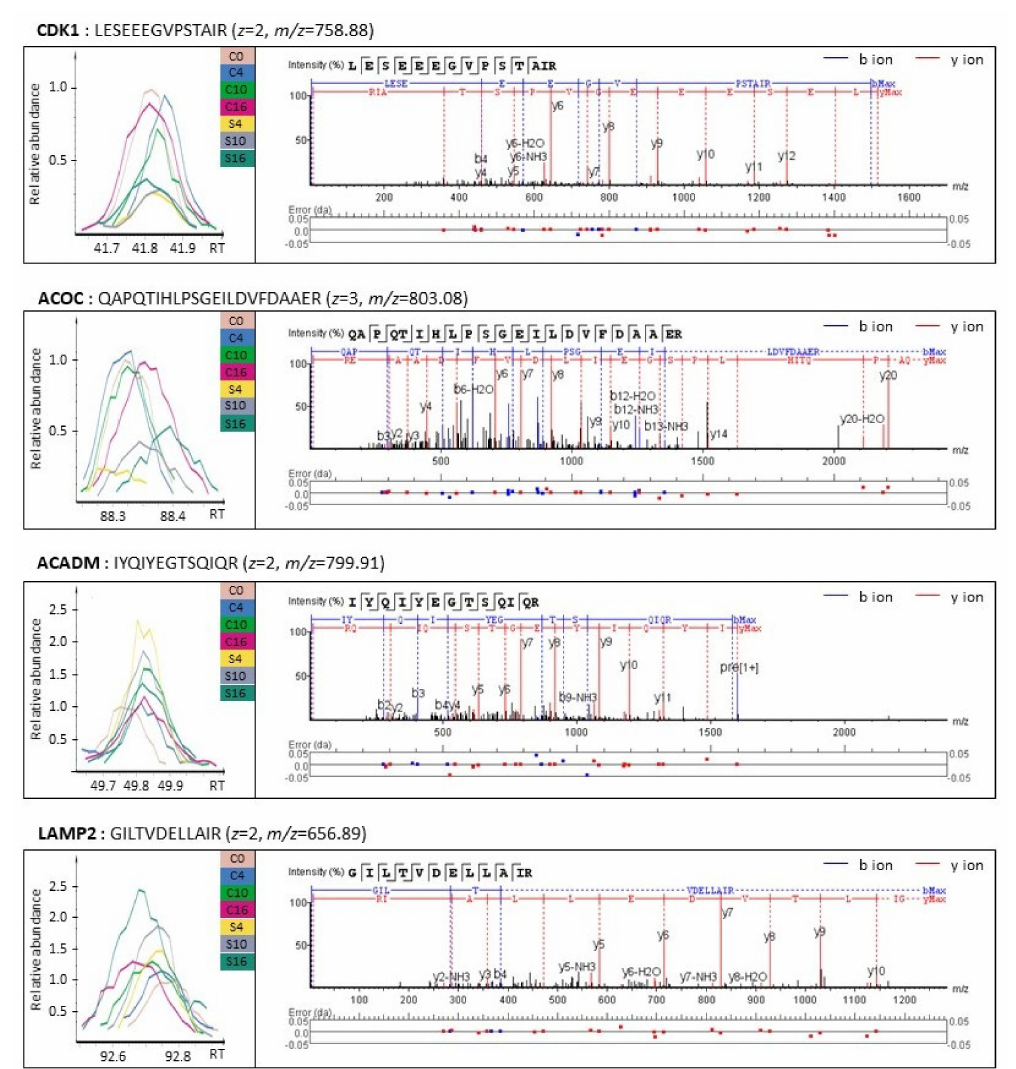
Figure 6. Representative MS and tandem MS spectra of downregulated (CDK1 and ACOC) and upregulated proteins (ACADM and LAMP2) in SiO 2 NP-treated groups, which are involved in cell cycle checkpoint, carbon metabolism, lipid metabolism, and lysosome. Data were obtained using the software PEAKS Studio 10.5. (Abbreviations: CDK1, cyclin- dependent kinase 1; ACOC, cytoplasmic aconitate hydratase; ACADM, medium-chain specific acyl-CoA dehydrogenase mitochondrial; LAMP2, lysosome-associated membrane glycoprotein